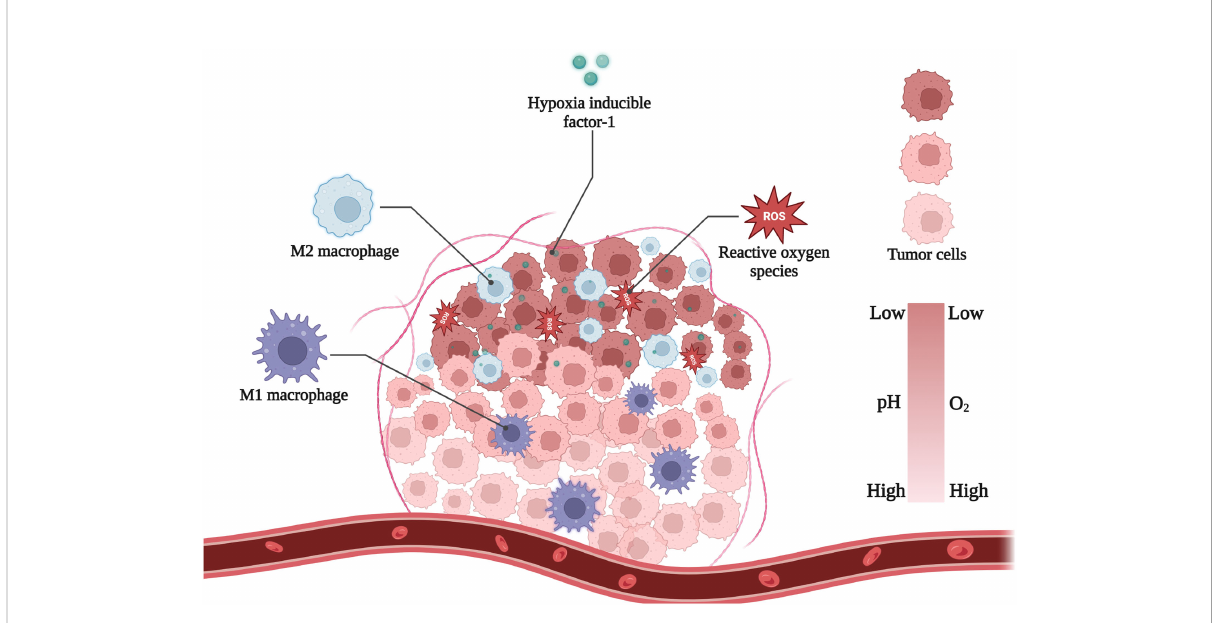
FIGURE 1 Main hallmarks of hypoxic TME. Figure created with